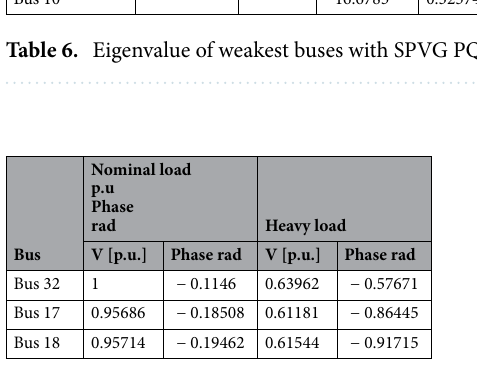
Table 7. Power flow results of the system installed with SPVG PQ-model and SVC.